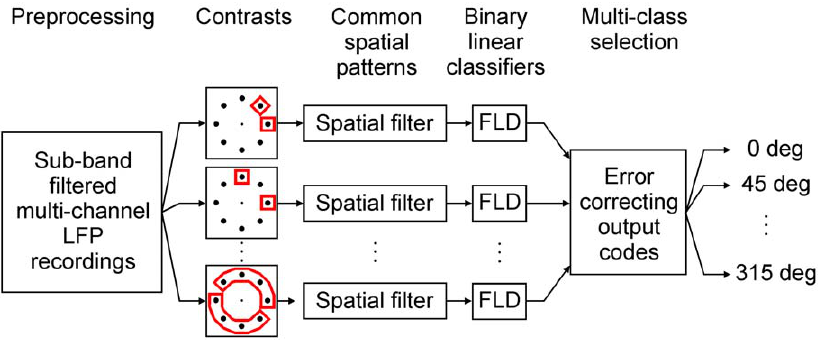
Figure 1. Schematic of the decoding algorithm. Sub-band filtered multichannel LFP were processed using spatial filters to decode movement target direction. Common spatial patterns (CSP) filters were constructed to contrast binary classes of target directions, as well as of groups of directions. The main features of the projected data from each spatial filter were fed to their related Fisher linear discriminant (FLD) classifier. Finally, the outputs from all FLDs were processed using the error correcting output codes (ECOC) for the multi-class decision. doi:10.1371/journal.pone.0014384.g001 PLoS ONE |